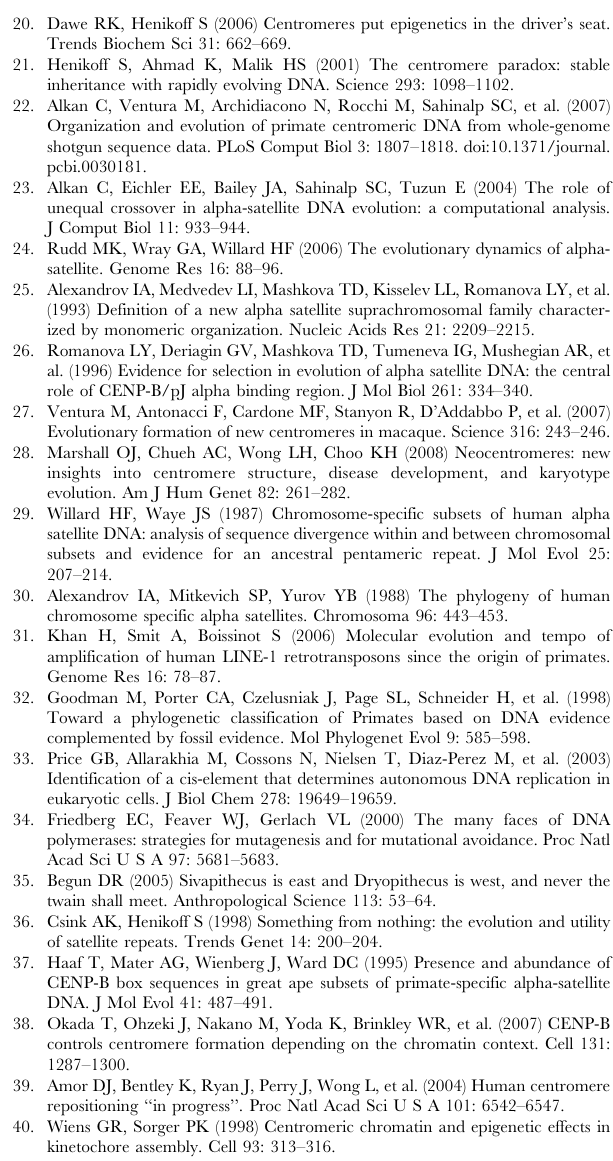
Table S4 Statistics of human L1 types in various primate genomes. *PA1 or L1Hs is a human-specific L1 species. ** There is no PA9 family, but PA8 and PA8A instead, which were treated collectively for the purposes of this analysis, because they were active simultaneously and their combined copy number about equals that of other families; the copy number of PA2, 6, and 10 is about twice as little [31]. Bold and underline: The figures for the youngest major family which was active in the genome of respective primate species are marked in boldface and for the minor youngest family are underlined. 1–3 copies were considered as possible classification mistakes or rare recombination events.